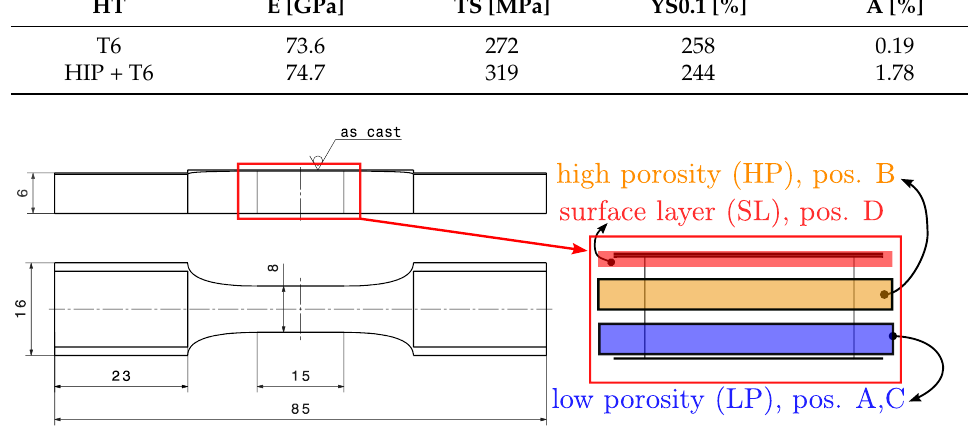
Figure 3. Initial specimen geometry with tested layers (dimensions in